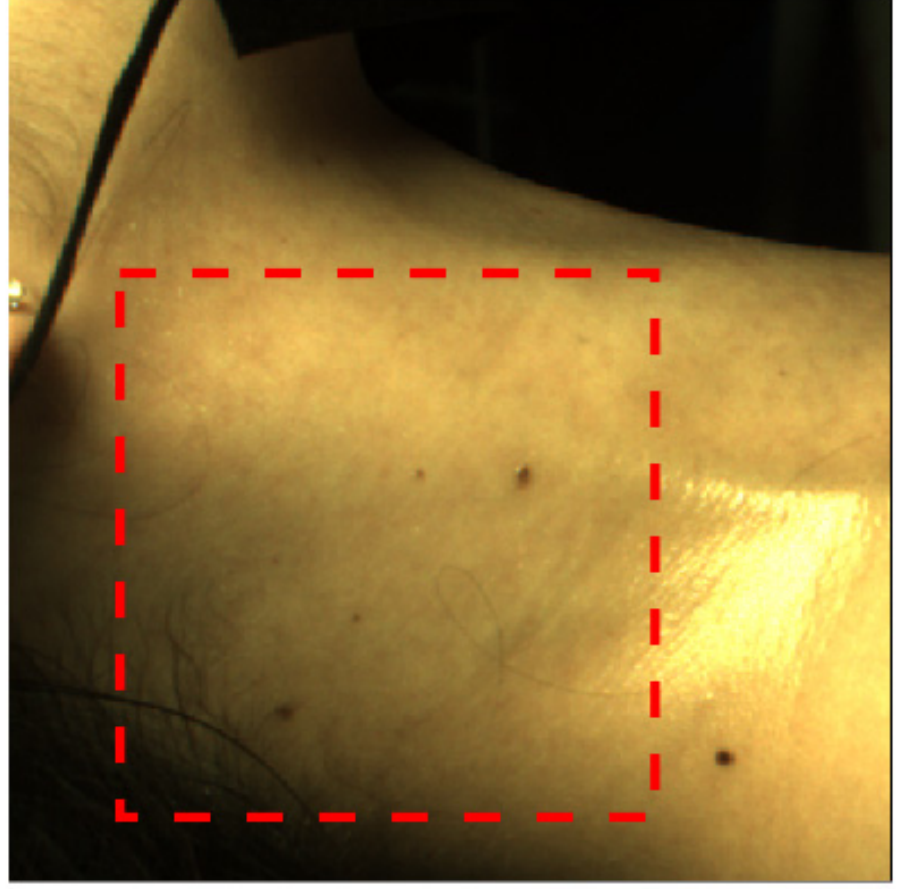
Figure 5. First collected frame, with the selected ROI shown in the red rectangle. Figure 6a shows the spatial distribution of SRVI signals based on correlation to the global SRVI signal. The correlations of local SRVIs to the global SRVI do not appear to be randomly distributed but rather form cohesive sub-regions with distinct boundaries. The results of spatially clustering the ROI into cohesive sub-regions is shown in Figure 6b,c. Figure 6b represents the sub-region that is visually recognizable as highly correlating to the global SRVI signal, while Figure 6c represents the sub-region that ranges from low to negative correlation to the global SRVI signal. The sub-region in Figure 6b is positioned where the carotid artery is expected to be placed, with the top of the sub-region ending at the top of the ROI, close to the temporomandibular joint (also where the carotid is positioned, per Figure 4). The positioning of the internal and external jugular veins can vary with respect to the carotid artery but generally occurs just posterior to the carotid (see Figure 4), aligning with the sub-region identified in Figure 6c. Figure 7 plots the ECG (a) simultaneously captured with SRVI (b,c), with (d–f) demonstrating the synchronization of the signals on specific cardiac cycles from the complete acquisition. The peaks and waves mentioned in the following text are all marked in (d–f), with the following text referring to the symbol for each peak and wave at first